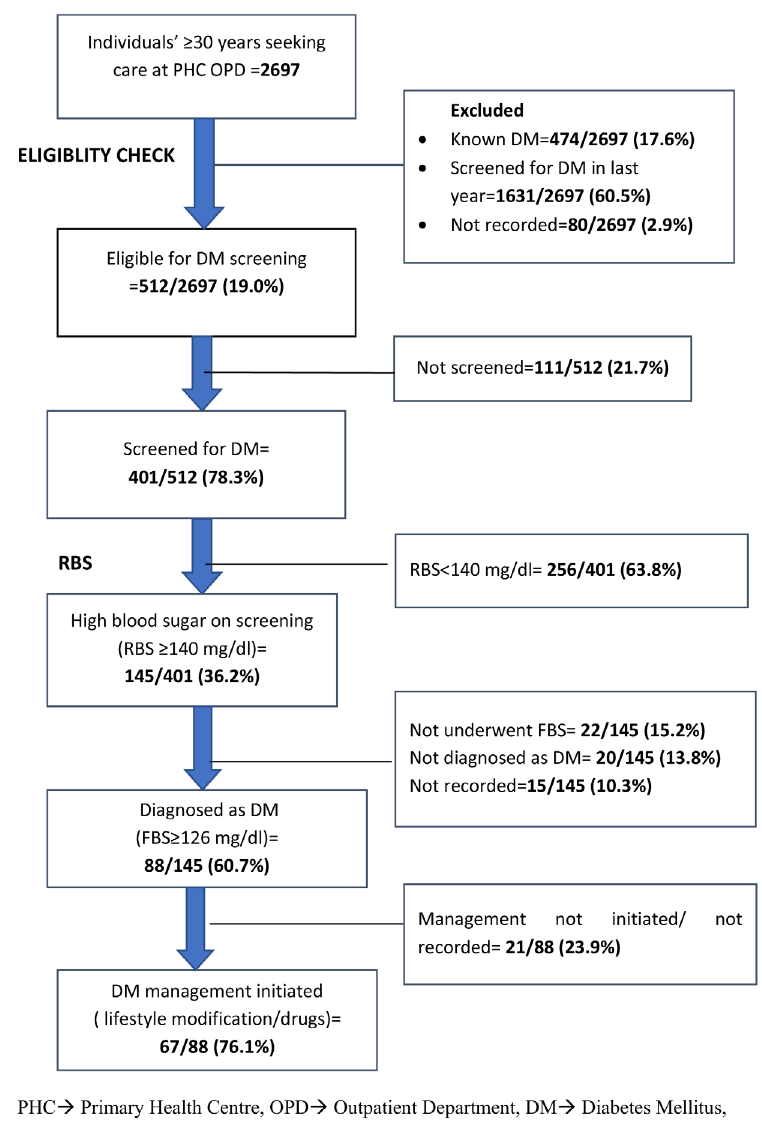
Figure 1. Flow diagram depicting the number eligible, screened, diagnosed and management for Diabetes Mellitus (DM) among persons aged =30 years seeking health care in the two selected primary health centres (PHCs) from March to May